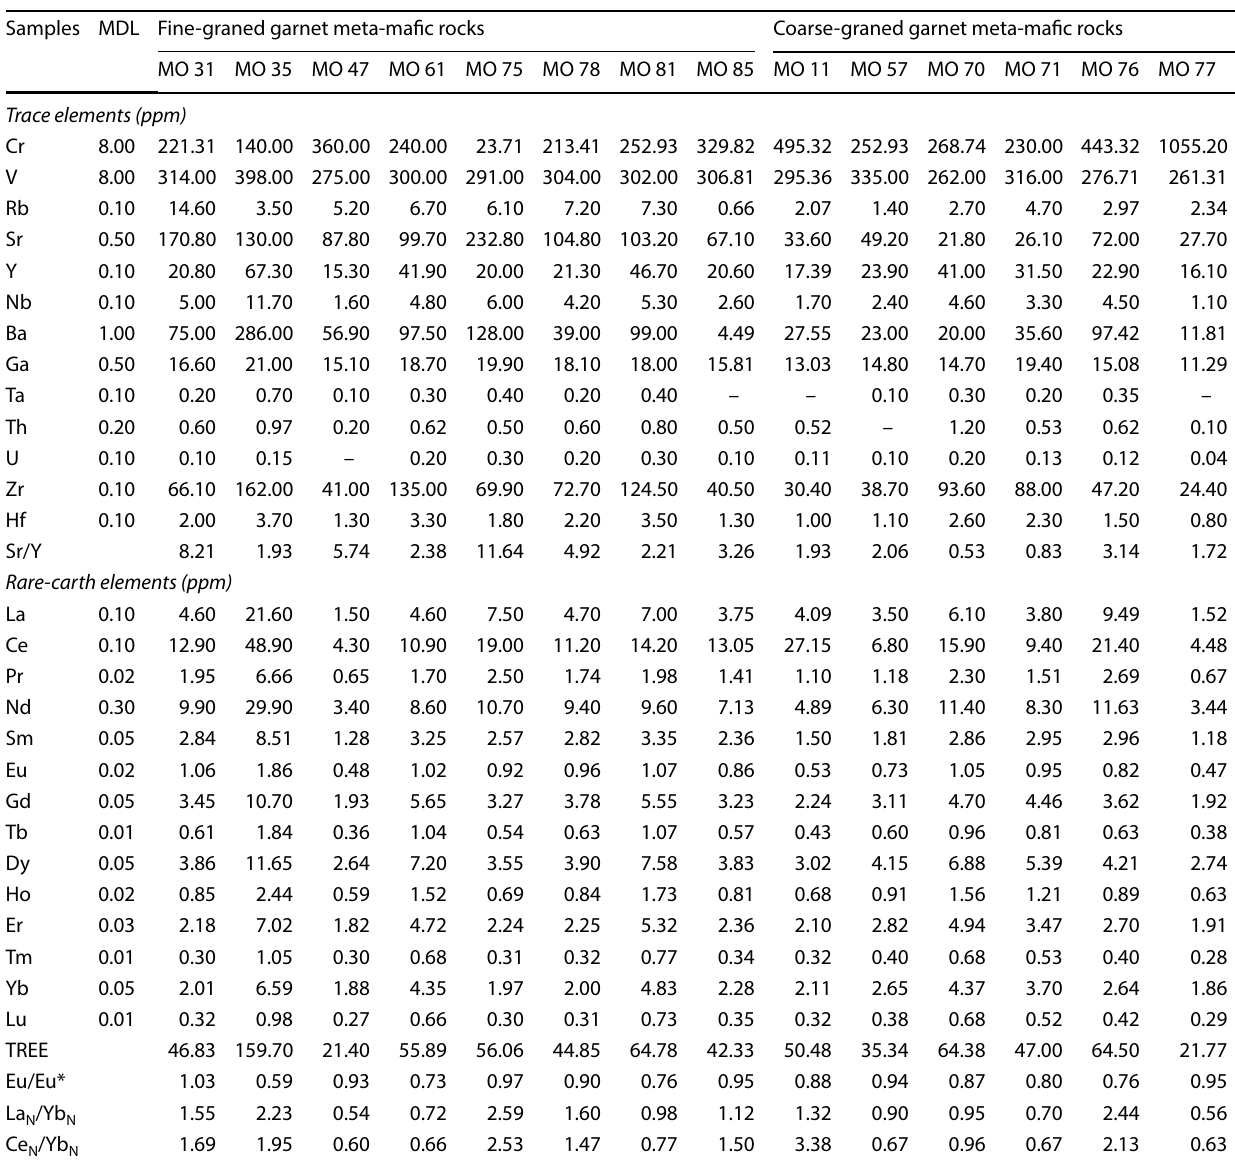
Eu/Eu* = (Eu(FGM/CFM)/Euchon)/(Sm(FGM/CFM)/Smchon) 1/2 (Gd(FGM/CFM)/Gdchon) 1/2